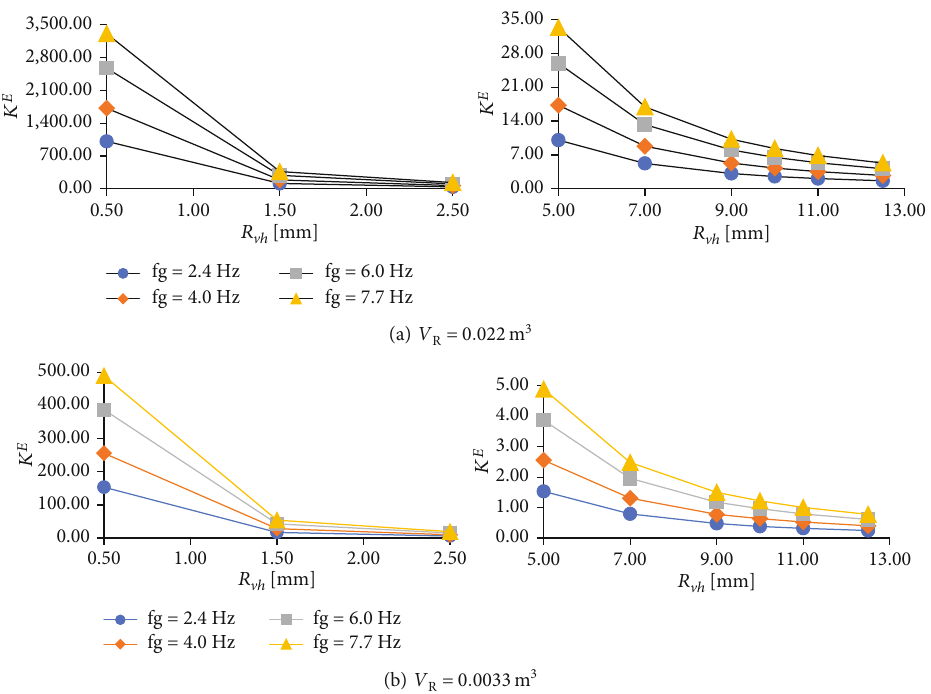
Figure 3: Variation of the characteristic vent time, K of the air reservoir: (a) V